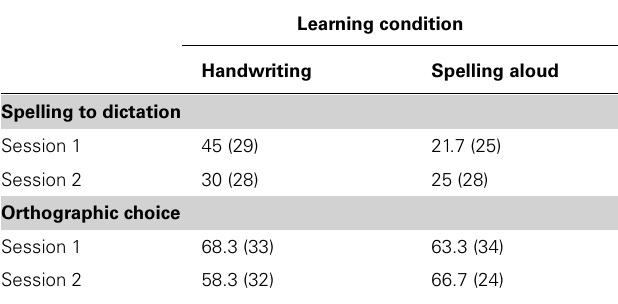
Table 3 | Experiment 1. Mean accuracy performance (percentages and standard deviations) in the spelling to dictation and orthographic choice tasks as a function of learning conditions and